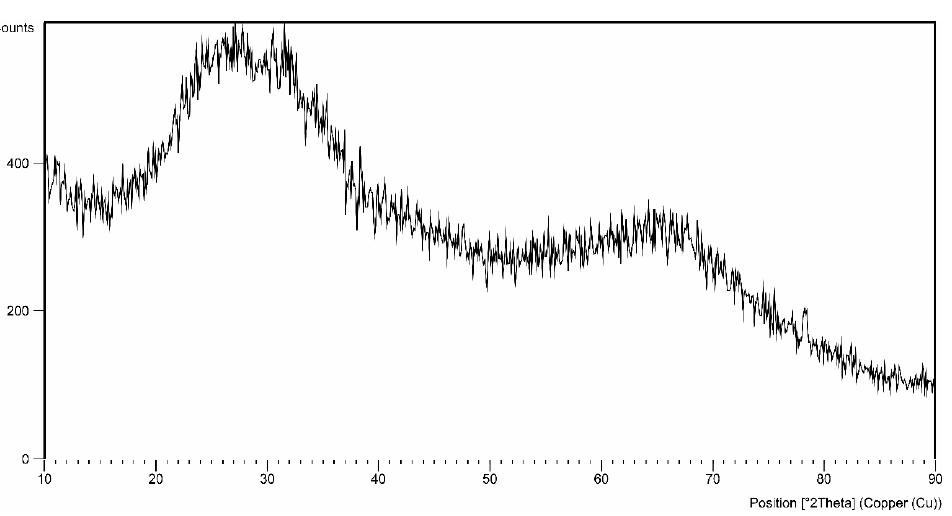
Figure 6. GIXD pattern for the angle of incidence α = 0.20 obtained. Aluminum oxide exists in an amorphous form and in several crystalline forms. Only